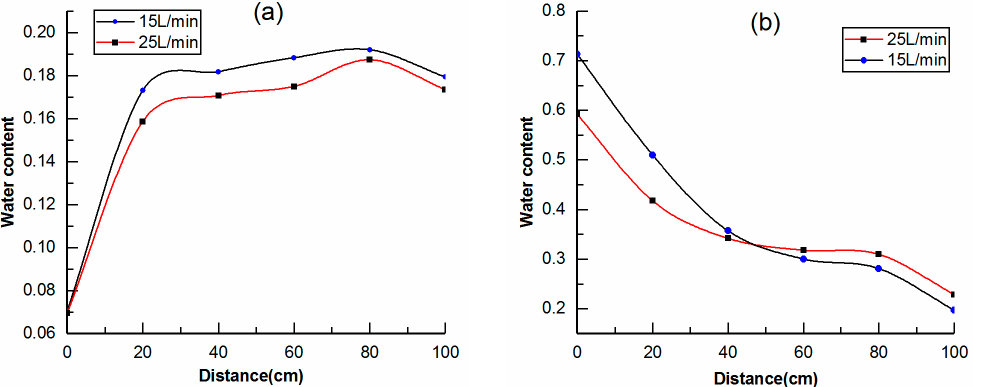
Figure 7. Water distribution after cold gas injection ( a ) Initial water content was 0.2, ( b ) Initial water content was 0.4.